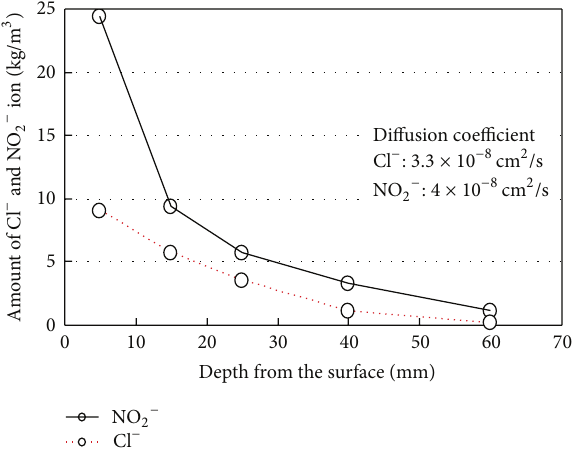
Figure 9: NO 2− and Cl − ions profiles in concrete at the end of exposure